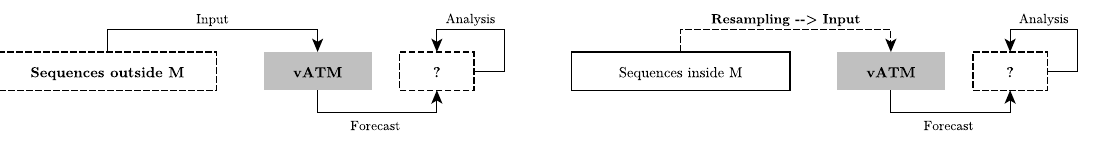
Figure 11. Observation-unrelated ( left ) and observation-altered ( right ) robustness stimuli of